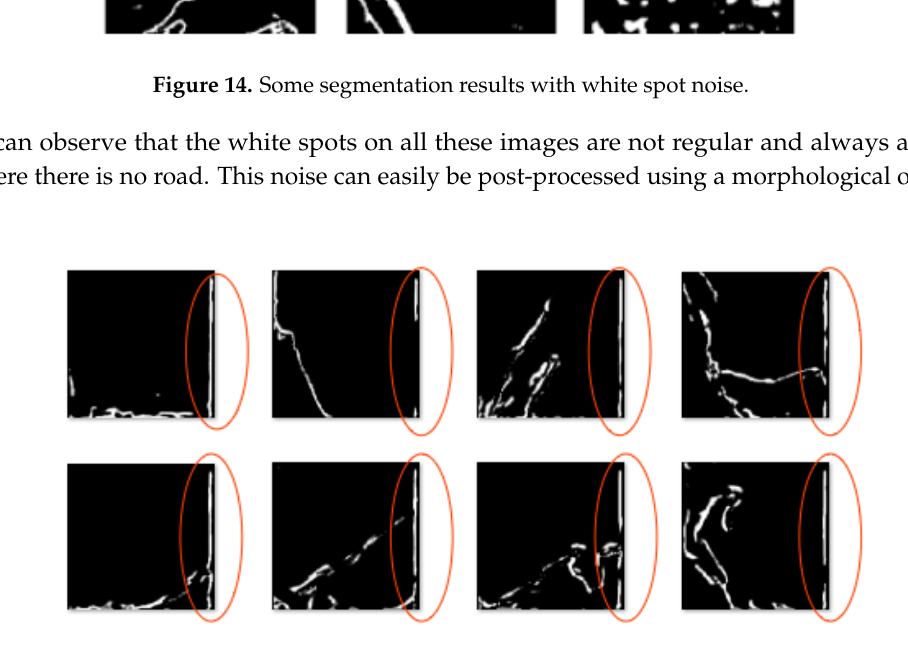
Figure 15. Some segmentation results with a vertical additional